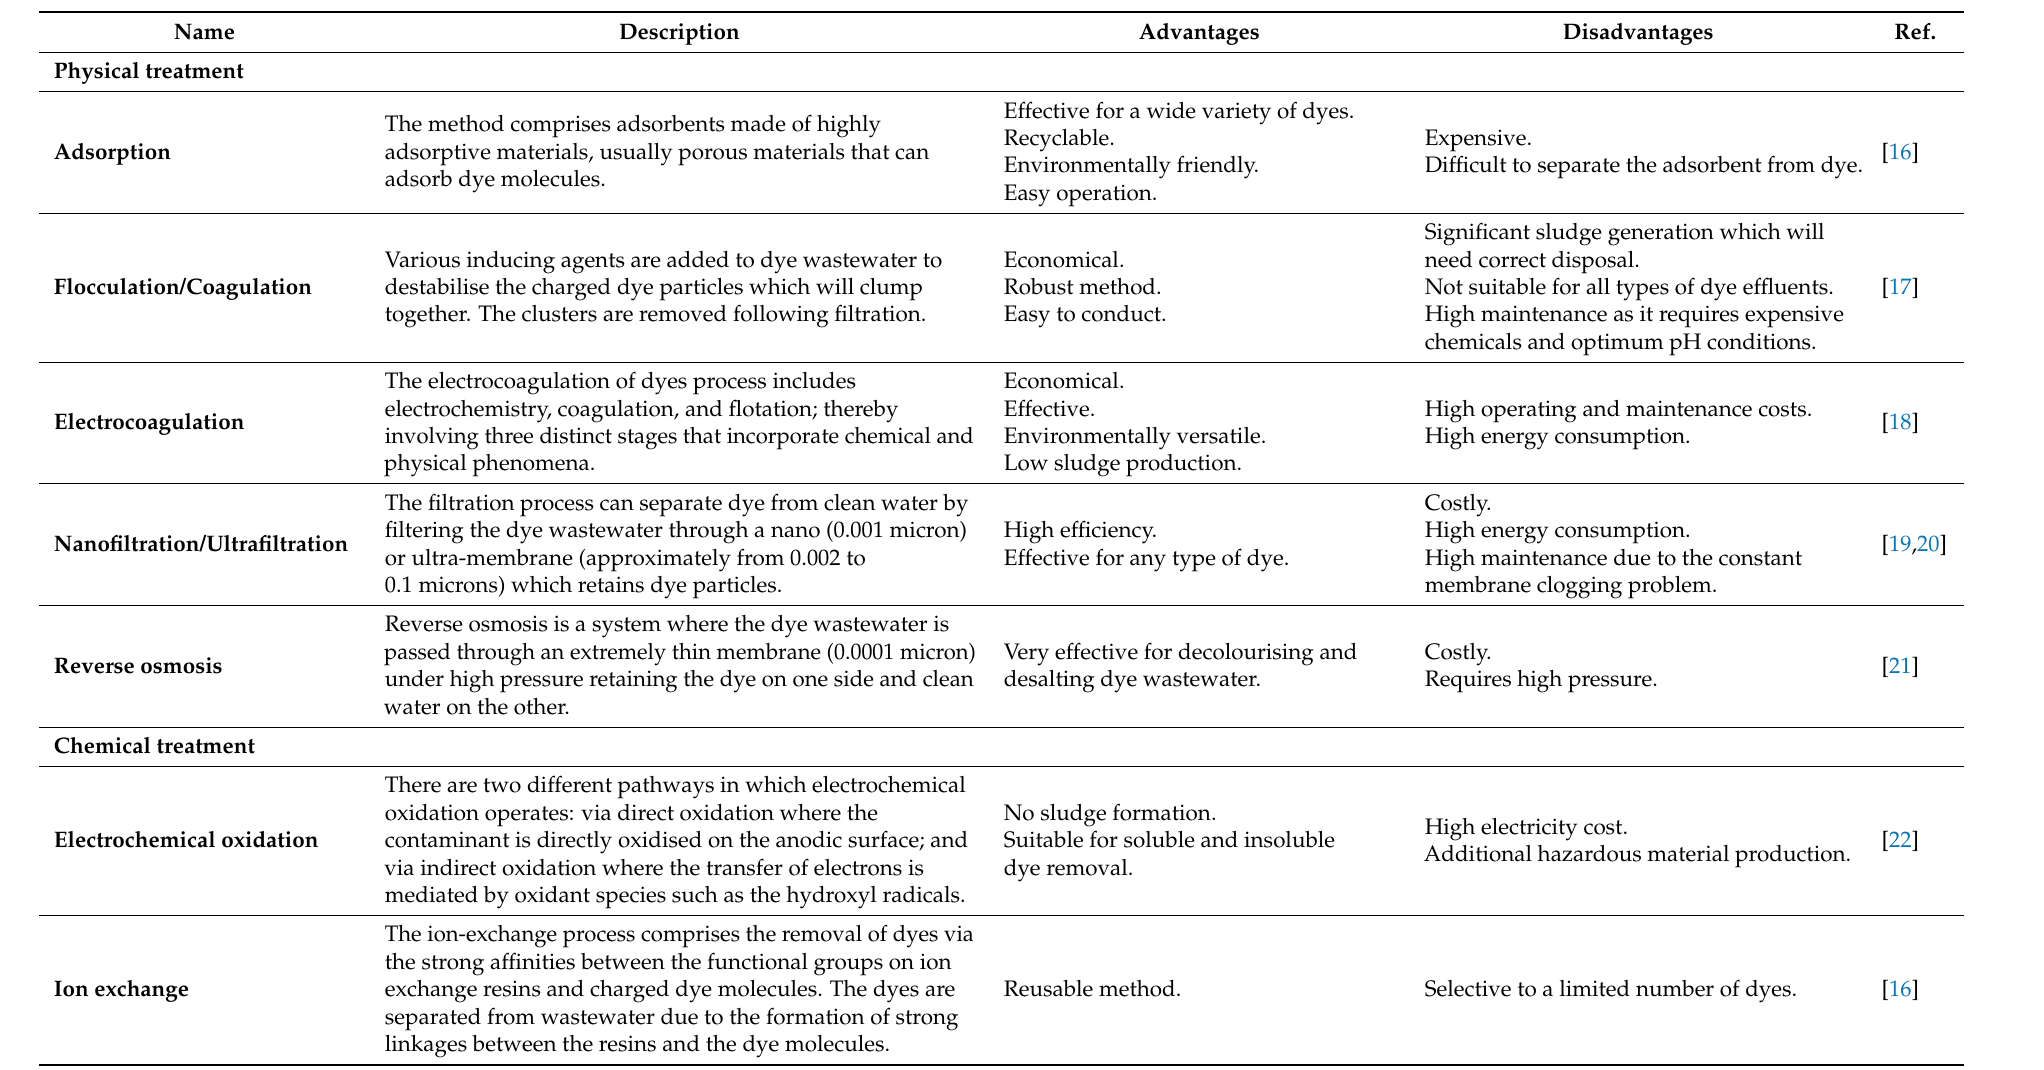
Table 1. Existing treatment processes for the remediation of dye-containing water and their advantages and